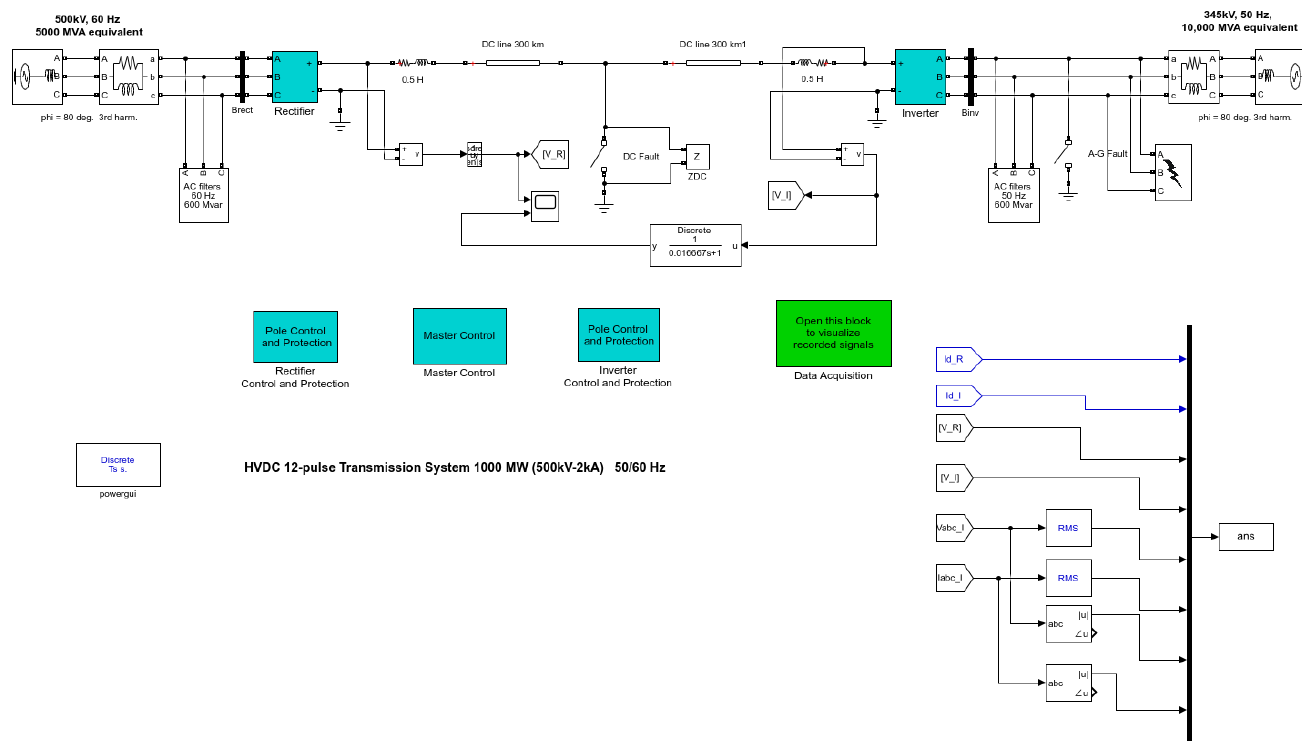
Figure 4. Simulink model for creating the faults.